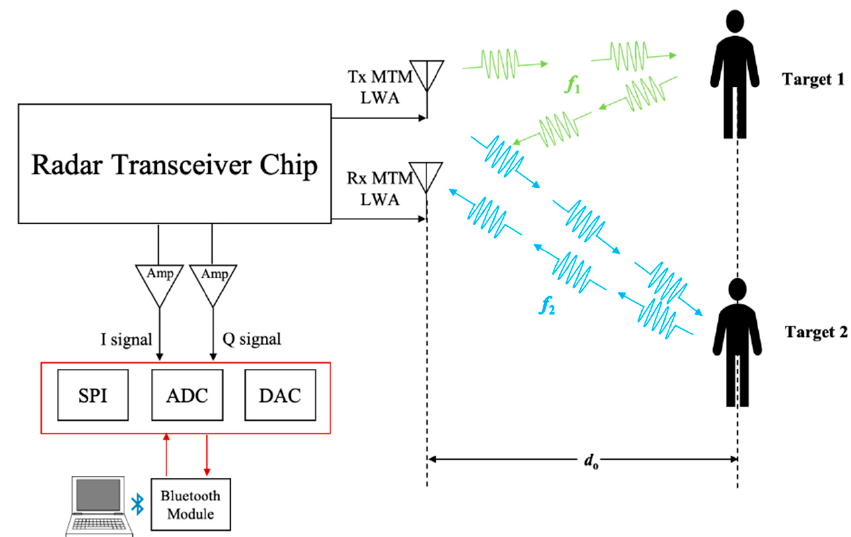
Figure 6. The block diagram of MTM LWA-based homodyne architecture at 24 GHz band.